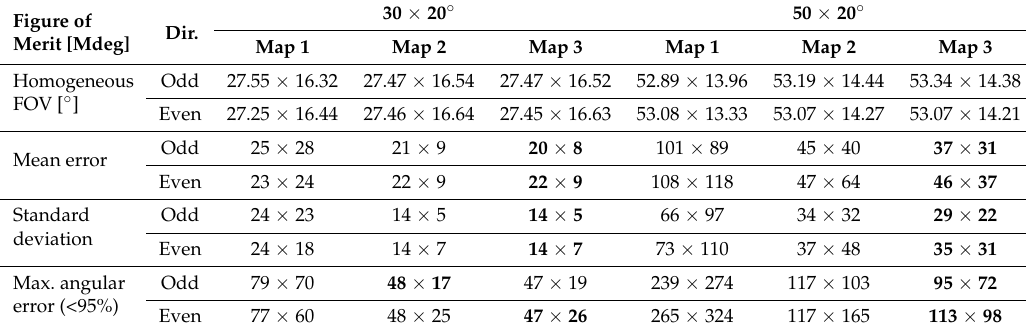
Table 1. Mapping results of the tested prototypes. Notice that units are millidegrees ( ◦ /1000) and the best performance is highlighted in bold for all figures except for the homogeneous FOV, which is in degrees and represents how far from the designed rectangular FOV is the distortion